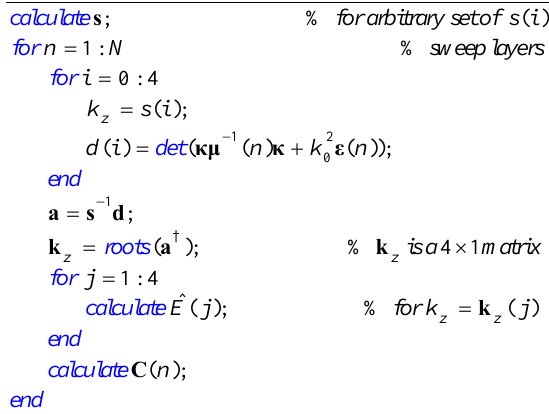
Figure 2: Pseudo-code for calculating characteristic